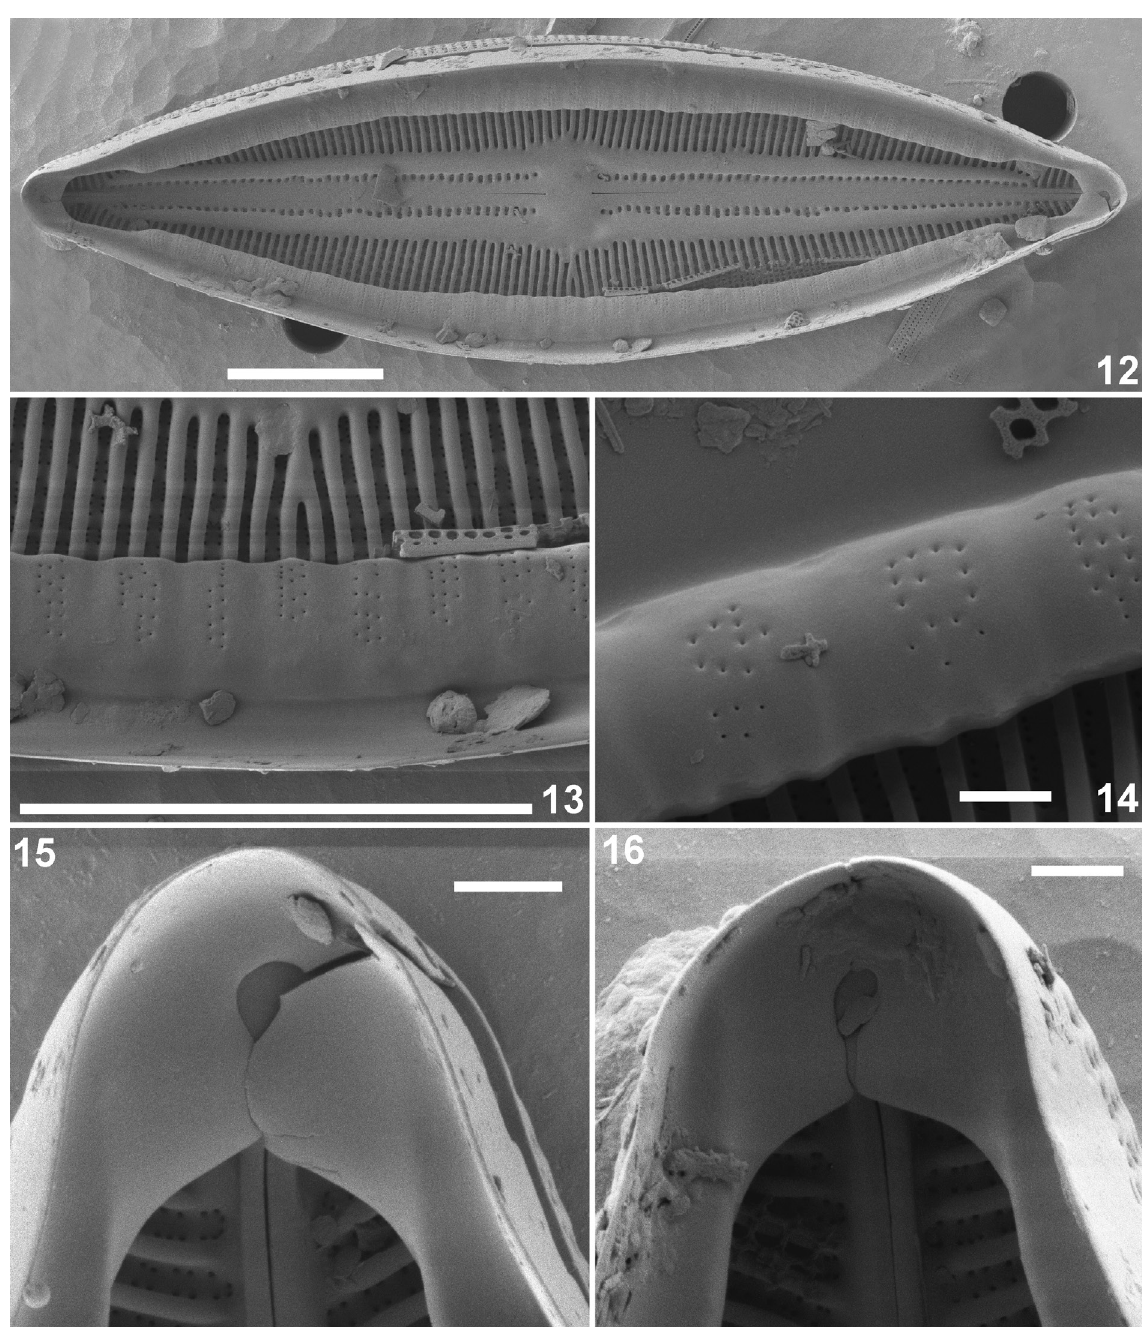
Figs 12–16. Mastogloia braunii Grunow. Scanning electron micrographs (SEM) of valves from the type population ( Grunow 23583 – capsule 0645 , Vienna, Austria). 12 . SEM internal view of an entire valve with the partectal ring and series of partectal pores. 13 . SEM internal detail of the partecta with the flange connecting the partecta with the valve margins. 14 . SEM internal detail of the partecta showing the partectal walls with 2–4 series of small, rounded pores. 15–16 . SEM internal details of the partectal ring near the valve apices showing the cleft with the lacunae. Scale bars: 12 = 1 µm; 13–16 = 10